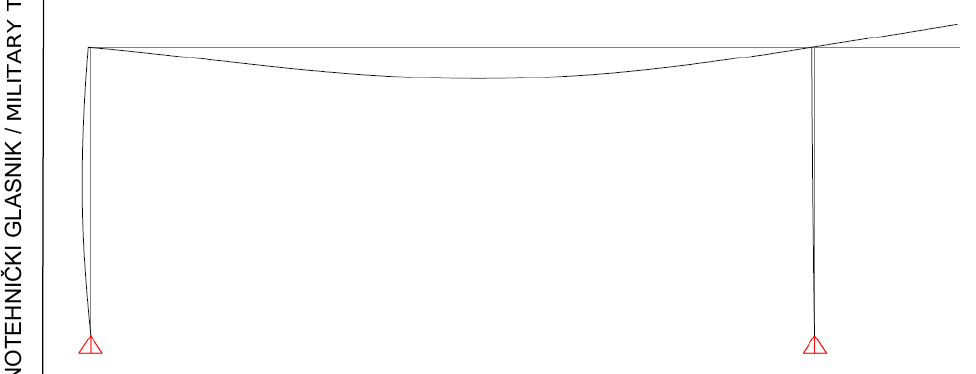
Figure 10 – 2 nd mode shape of the carrying structure Рис. 10 – 2 формa колебаний несущей конструкции крана Слика 10 – Други облик осциловања носеће конструкције